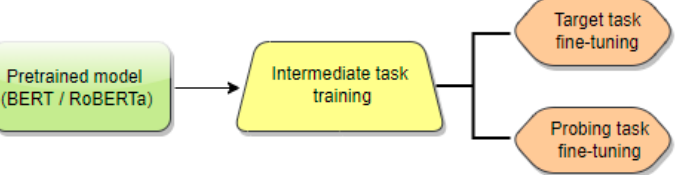
Figure 7. Intermediate-task transfer learning and subsequent fine-tuning (a pre-trained model (BERT), is fine-tuned on the target task for intermediate task training. The model is then fine-tuned separately for each target and probing task. The target tasks o ff er great importance to NLP applica- tions.).